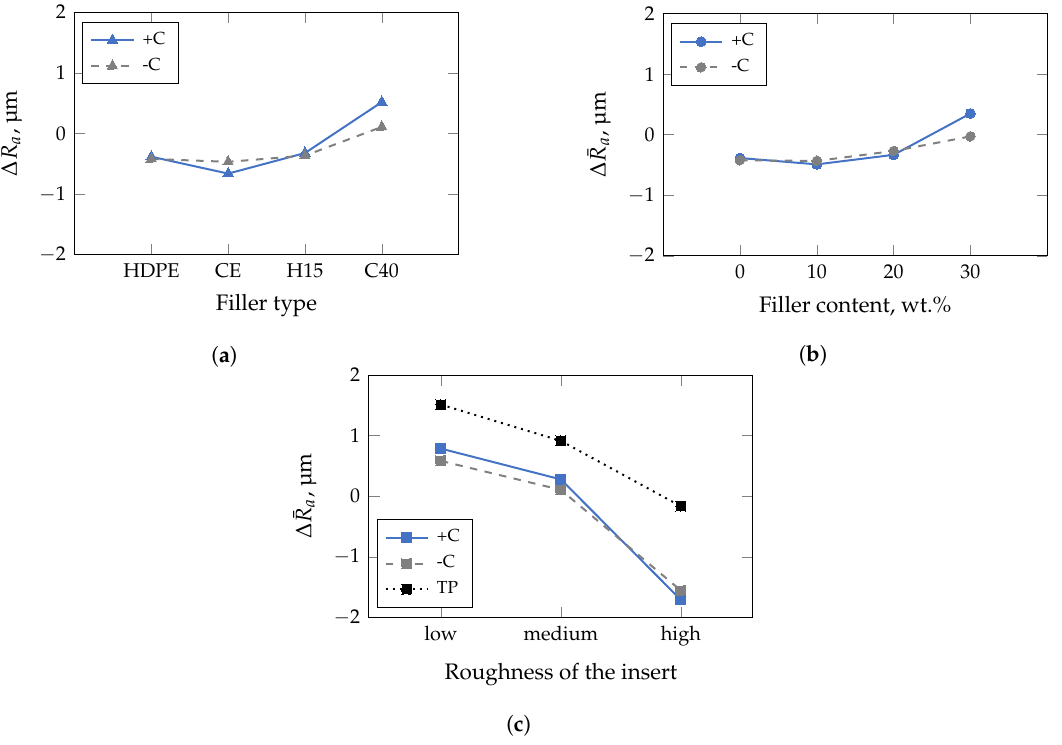
Figure 12. Results of multivariate analysis of variance performed with a confidence interval of 95% including different insert rougnesses. Compatibilizer dependence is marked with +C (with), and − C (without). ( a ) Combatibilizer impacts ∆ ¯ R a stronger in comparison to the filler used. ( b ) The impression quality is influenced by the compatibilizer above a critical filler content. ( c ) A similar dependence, as observed in the studies of the commercial thermoplastic (TP) materials (cf. Figure 5a), is given for the filled samples with and without